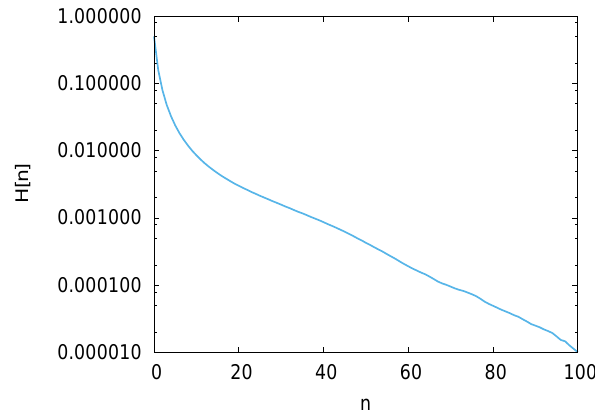
Figure 11: Histogram over the expansion orders for the same system as in Fig. 9.